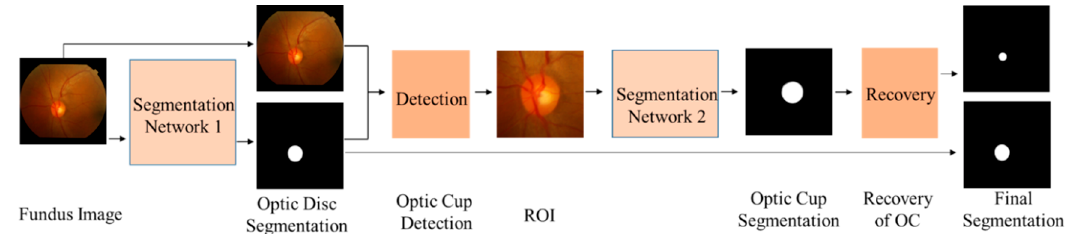
Figure 2. Flow chart of optic disc and optic cup segmentation in two stages.